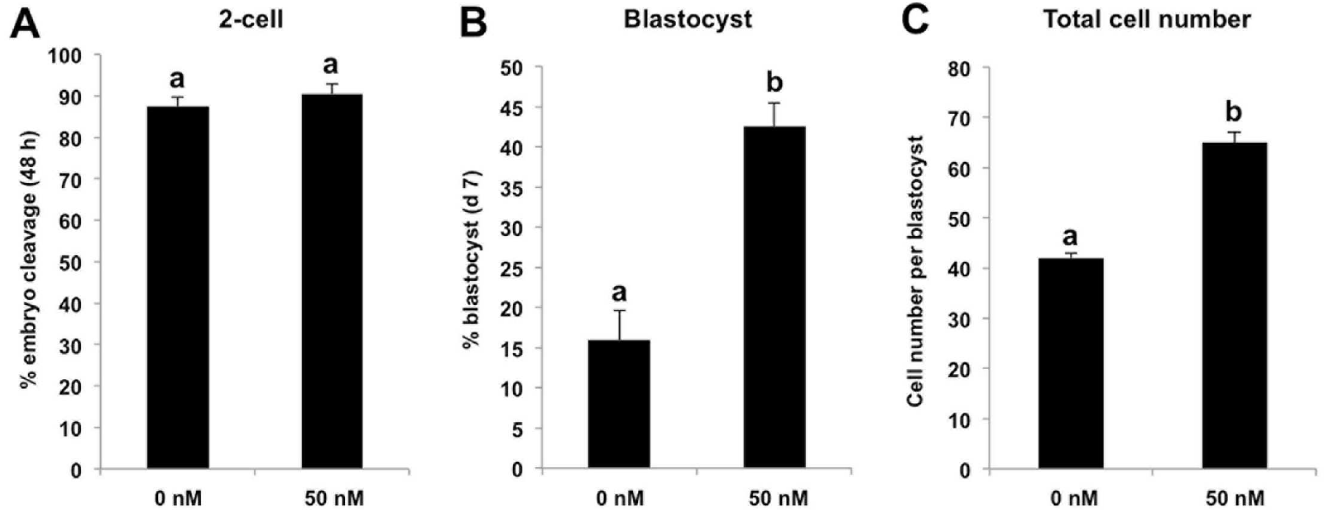
Fig 1. TSA treatment alone improves early developmental efficiency of SCNT embryos. SCNT embryos at the pronuclearstage were cultured in PZM-3 supplemented with 50 nM TSA for 24 h and embryoscultured in PZM-3 containing DMSO were served as NT control, then TSA and DMSO were washedout and embryos were culturedin fresh PZM-3 medium until day 7. The effect of HDACs inhibitionon the proportionof embryos that reachedthe 2-cell stage within 48 h after activation (A) , proportionof embryosdevelopingto the blastocyst stage (Day 7) (B) and total cell numberper blastocyst (C) are shown. The experiment was repeatedat least three times with 200 embryos per group. All the percentage data are expressedrelative to the number of 1-cell embryosand are shown as mean ± S.E.M. Values with different superscripts across treatments indicate significantdifferences ( P < 0.05).